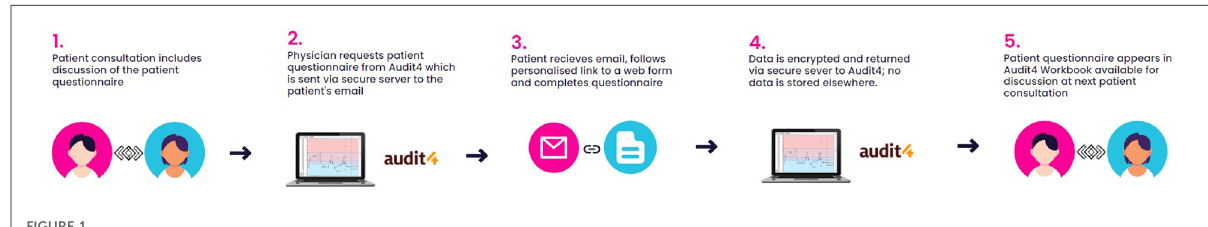
FIGURE 1 Electronic patient reported outcome delivery system work fl ow in